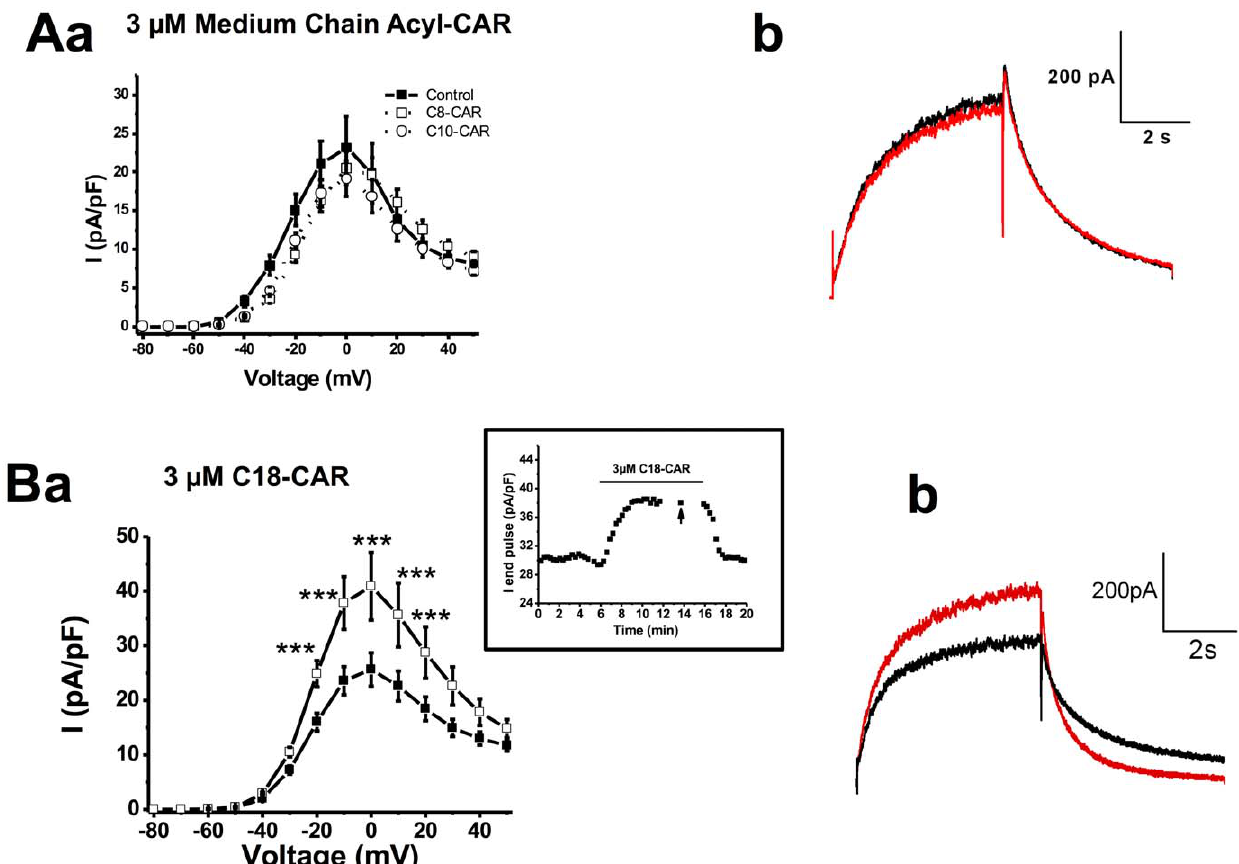
Figure 1. Effect of extracellularacyl-CARs on I hERG . I hERG -V relationships,in all graphs, the filled squares represent the current in the absence of acyl-CAR in the pipette (control, n=12 cells). Aa , effect of 3 m M C8-CAR (empty circles, n=8 cells) or 3 m M C10-acyl-CAR (filled circles, n=7 cells); Ab , typical example of C8-CAR (red) compared with PSS (black). Ba, effect of 3 m M C18-CAR (filled circles, n=9 cells) on I hERG -V relationship. The inset shows the effect of 3 m M C18-CAR on end-pulse hERG current elicited by a depolarisation to 2 10 mV from a holding voltage of 2 70 mV, obtained on a representative cell (the arrows indicate the current obtained at 2 10 mV during an IV protocol, see Methods), ***, p , 0.001. **, p , 0.01. Bb , typical example of C18-CAR (red) compared with PSS (black).